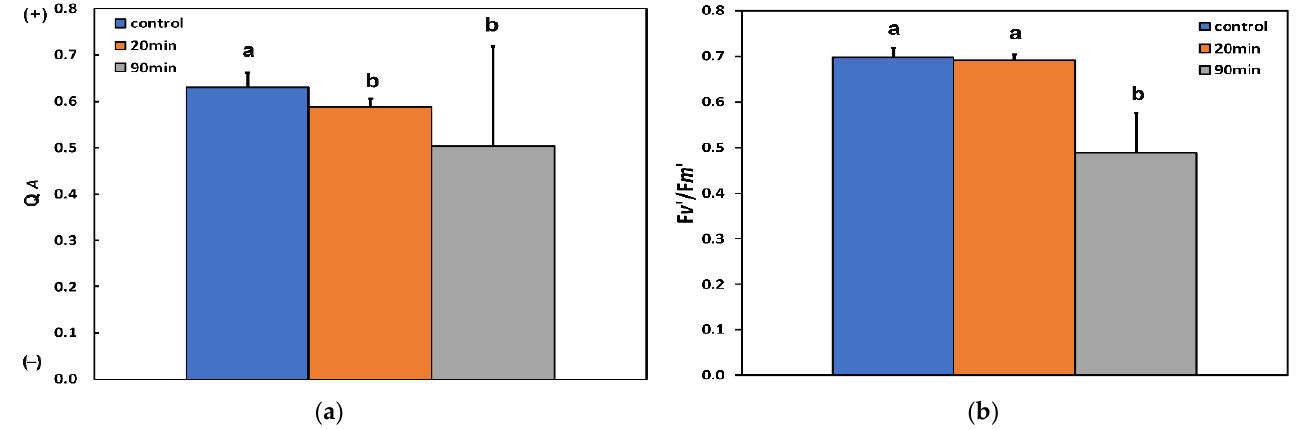
Figure 3. Changes in ( a ) the Q A ; and ( b ) the F v ′ /F m ′ ; of potato leaves, at the whole leaf level, before (control) and after 20 and 90 min feeding by Halyomorpha halys . Error bars ± SD ( n = 5). In each parameter, the columns with different lowercase letters are statistically different ( p < 0.05).